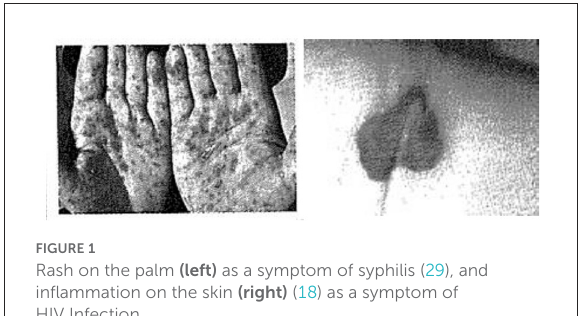
FIGURE1 Rash on the palm (left) as a symptom of syphilis (29), and inflammation on the skin (right) (18) as a symptom of HIV Infection.